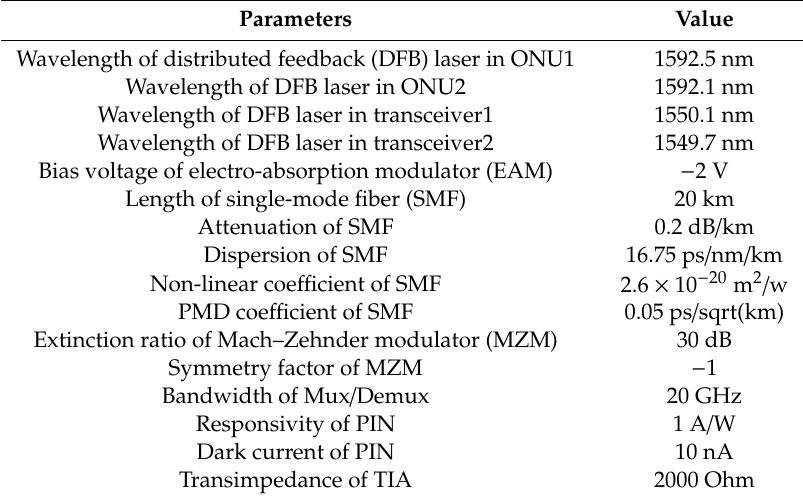
Table 3. Main parameters list of the simulation